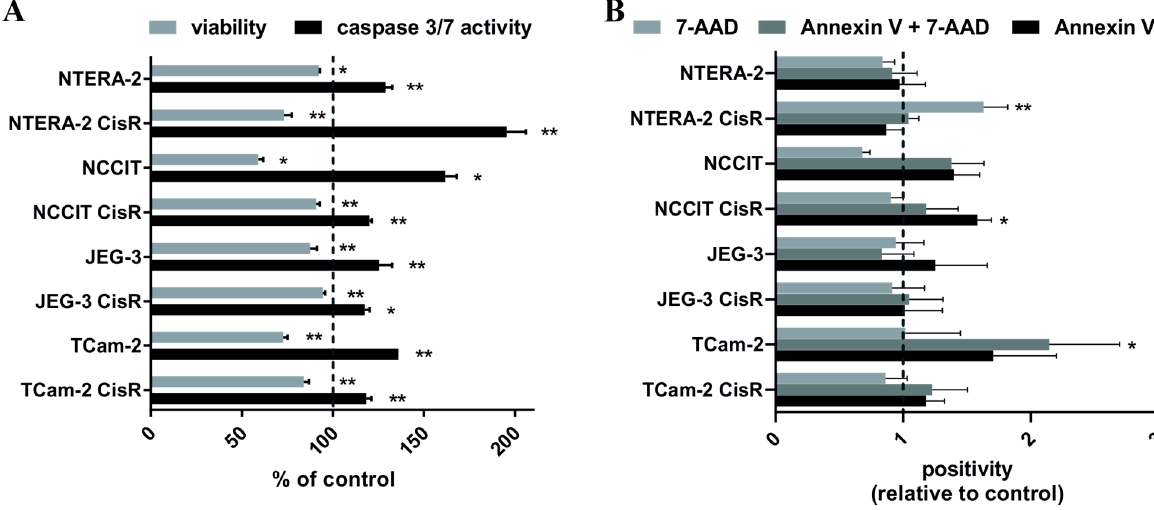
Figure 6. PRI-724 significantly activated caspase 3/7 and induced cell death. ( A ) Luminometric measurement of viability and caspase 3/7 activity in GCT cell lines treated with PRI-724 showed increased activity of this caspase after cisplatin PRI-724 treatment, where NTERA-2 CisR cells showed the highest activity. Values were expressed as percentage of the untreated cells (control) ± SD. ( B ) Annexin V assay revealed significant increase in population of NCCIT CisR cells in early apoptosis, increase in late apoptosis/necrosis in TCam-2 cells and necrotic population of NTERA-2 CisR cells after PRI-724 treatment. Values were expressed as relative positivity of the untreated cells (control) ± SD. 7-AAD = necrosis, Annexin V + 7-AAD = late apoptosis/necrosis, Annexin V = early apoptosis. * p < 0.05, ** p < 0.01.